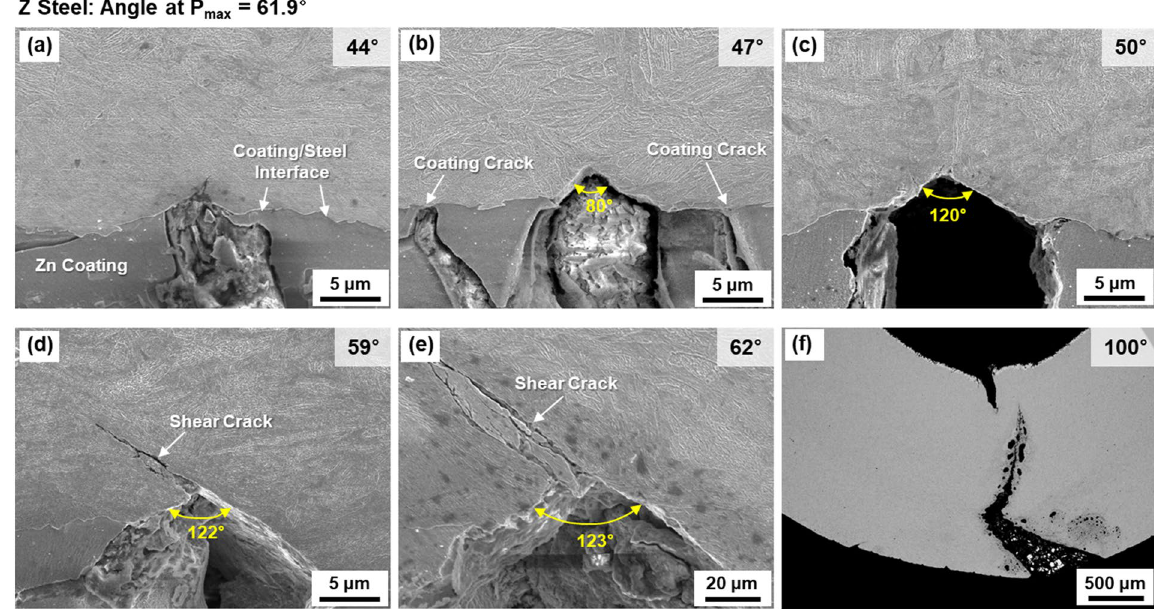
Figure 5. ( a – f ) SEM micrographs illustrating sequential V-cracking processes at various bending angles in the Z steel. Bending procedures are classified into four stages: ( a , b ) formation of small V-crack, ( c ) increase in number and size of V-cracks, ( d ) initiation of shear-crack propagation from the V-crack tip, and ( e , f ) further propagation and opening of shear crack to reach the